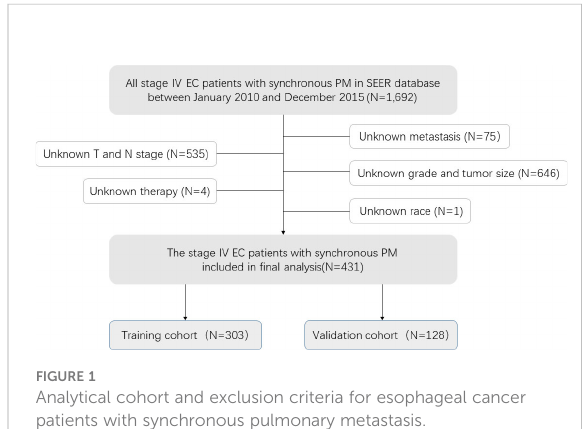
FIGURE 1 Analytical cohort and exclusion criteria for esophageal cancer patients with synchronous pulmonary